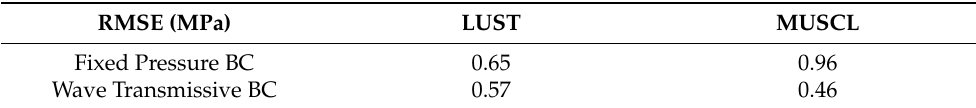
Figure 6. The data correspond to p dif f = 7 MPa, 12 mm computational exit chamber length. Left : Contour plots of the simulated vapour fraction, as well as shadowgraph pictures from the experiment [11]. Right : Pressure profiles along the centreline of the nozzle, including experiment [11]. The notation wT and fP corresponds to wave transmissive and fixed pressure boundary conditions respectively. The two vertical black lines denote the nozzle entry and exit respectively. Table 4. Root Mean Square Error against experimental data at the centreline of the nozzle injection pressure of 7